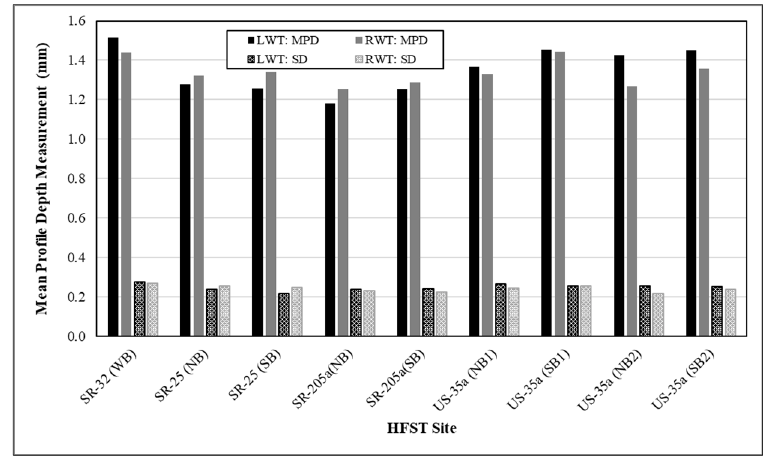
Figure 1. Mean profile depth (MPD) measurements in left and right wheel tracks.